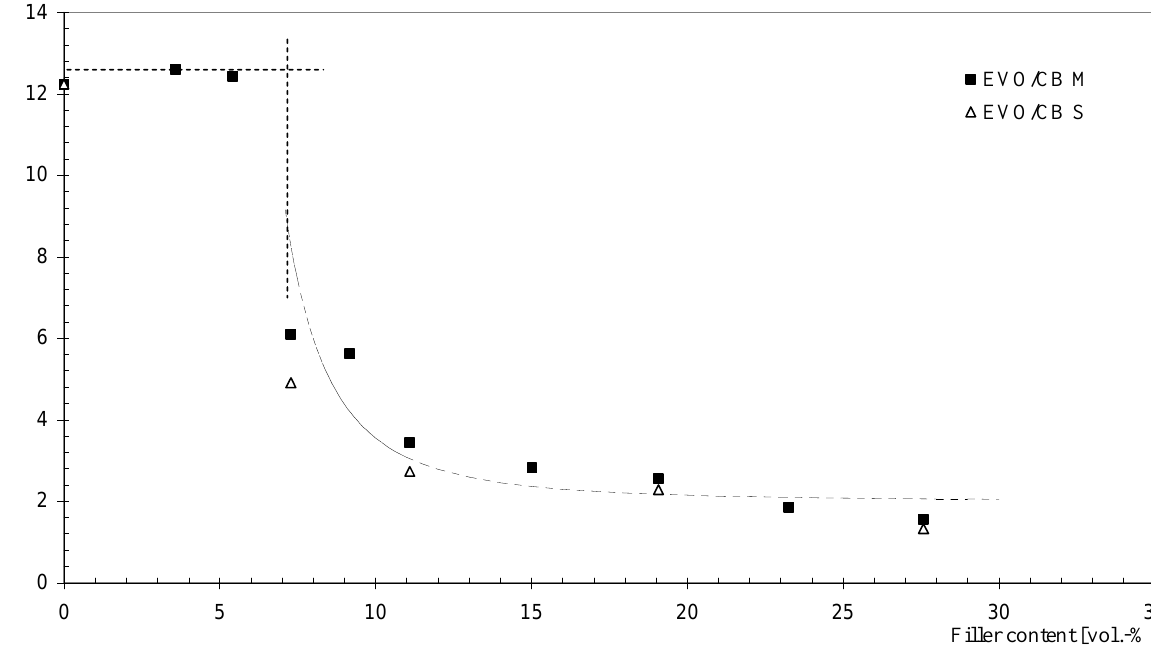
Figure 3 . Electrical resistivity vs. filler concentration for EVO/CB